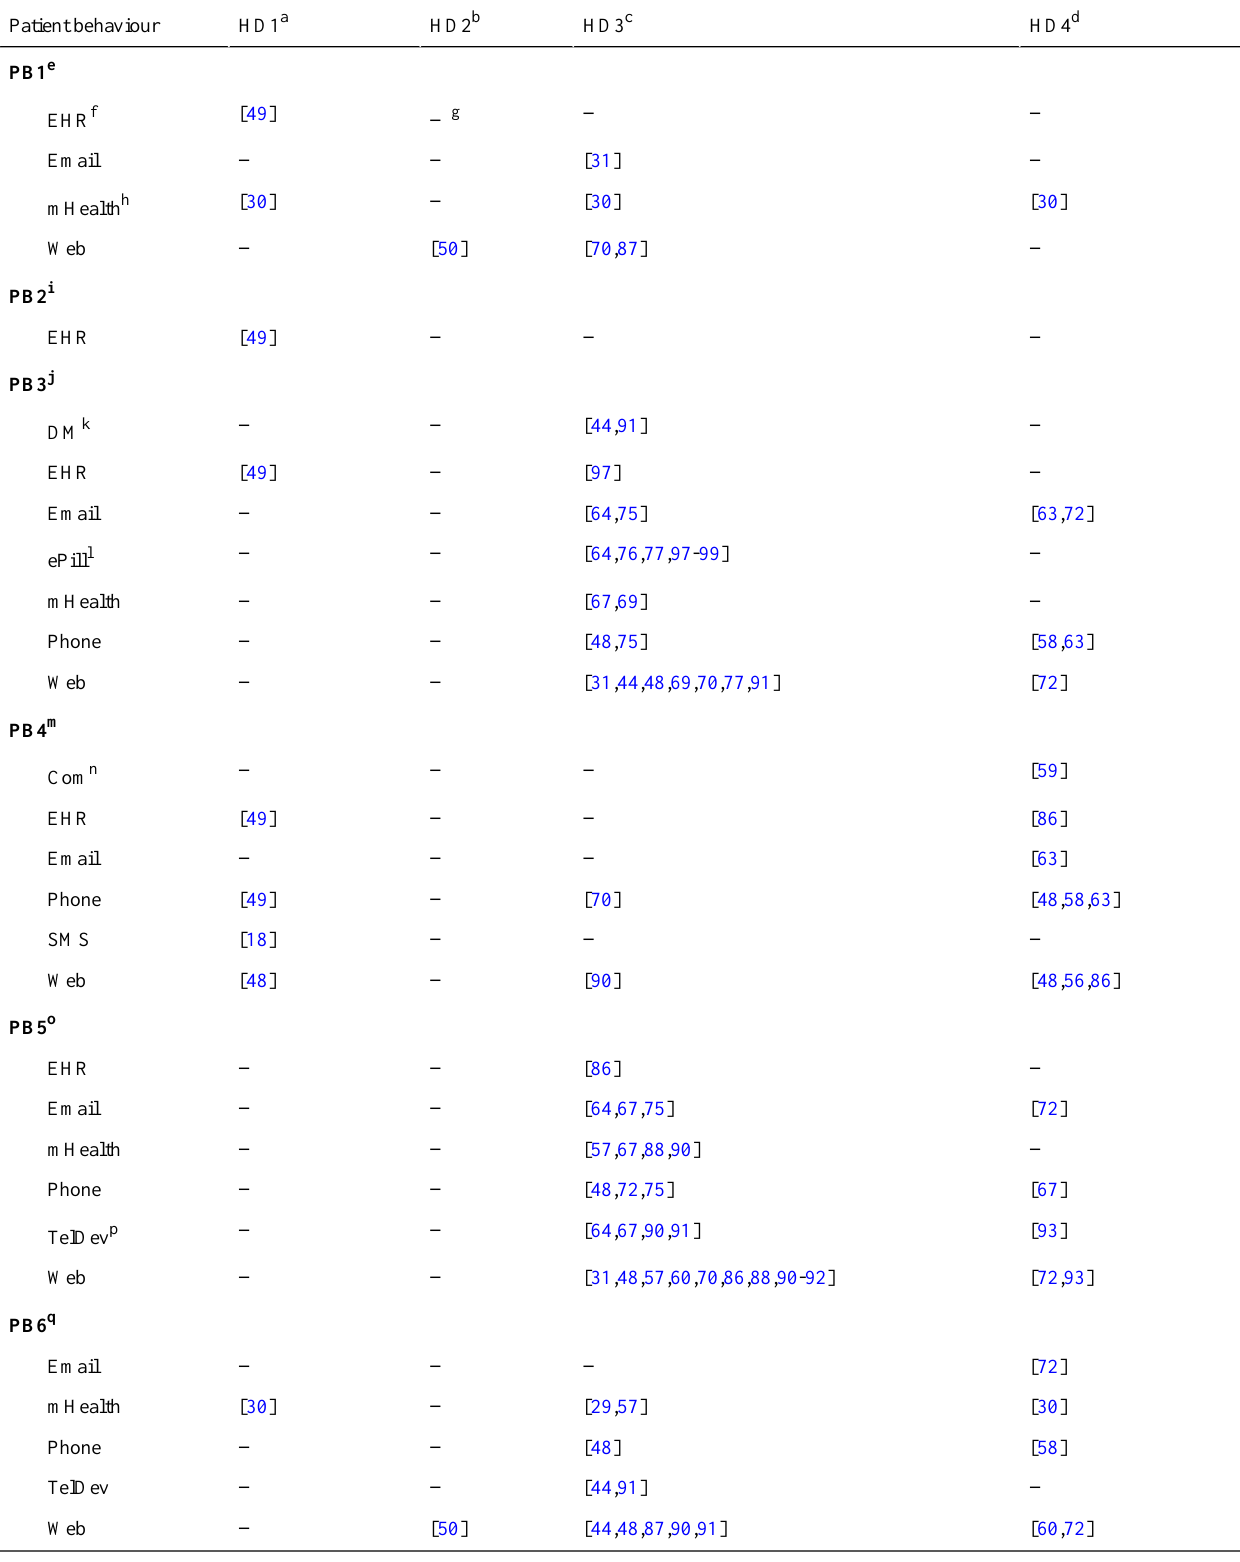
Table 2. Matrix of change objectives at the health care team and system level, with the studies targeting medication adherence and blood pressure improvement in patients with hypertension categorized by digital intervention delivery